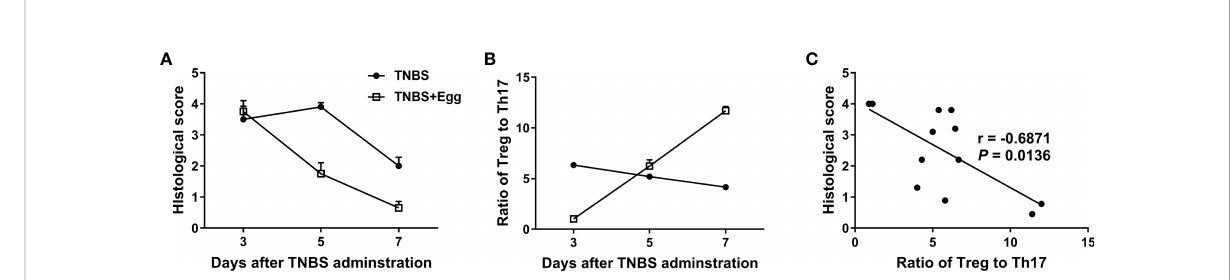
FIGURE 4 The colon in fl ammation had a correlation with the Treg/Th17 ratio in the TNBS-induced experimental colitis. Dynamics of histological scores (A) and ratio of Treg to Th17 (B) in mice with the experimental colitis at the indicated time points. (C) Correlation analysis of the histological scores and the ratio of Treg to Th17 in the experimental colitis.